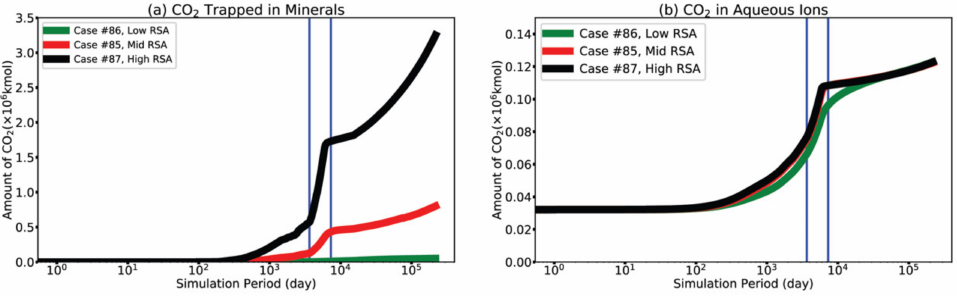
Figure 11. Performance comparison of ( a ) CO 2 mineral trapping and ( b ) CO 2 trapped in